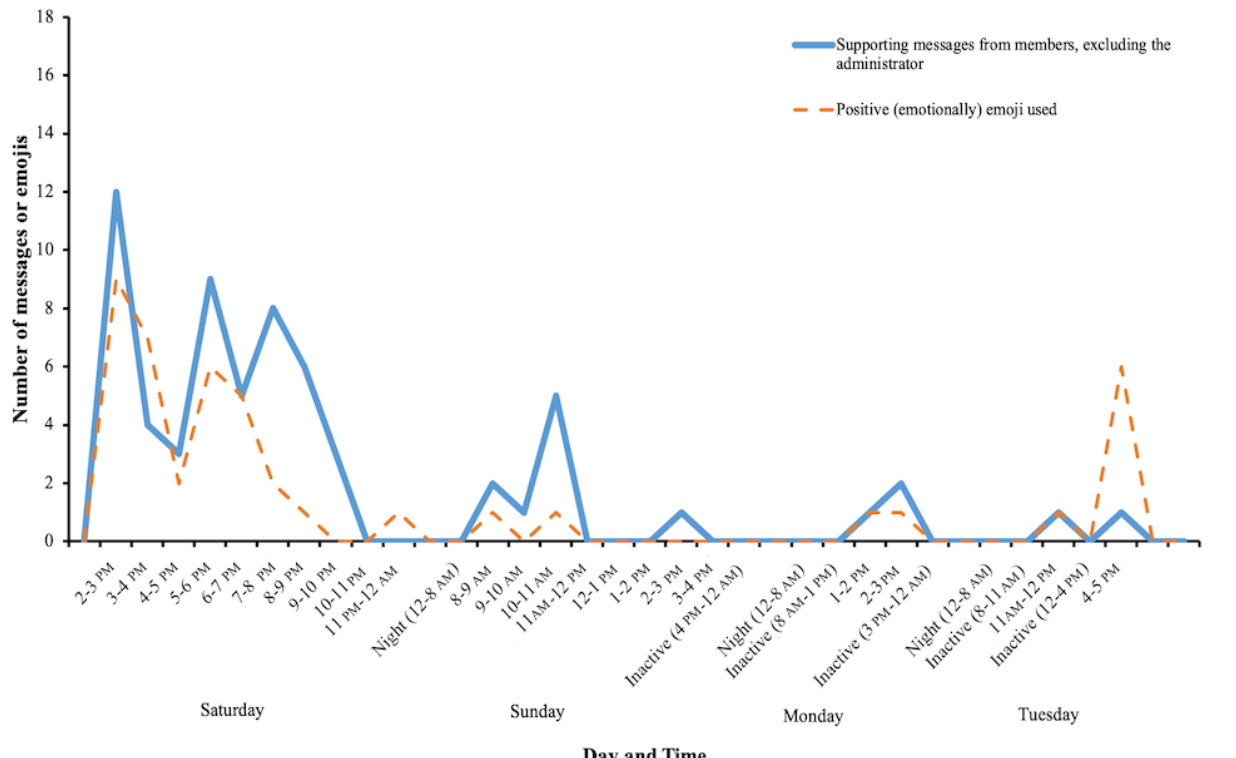
Figure 4. Number and time distribution of messages from the members supporting the administrator and of positive (emotionally) emojis